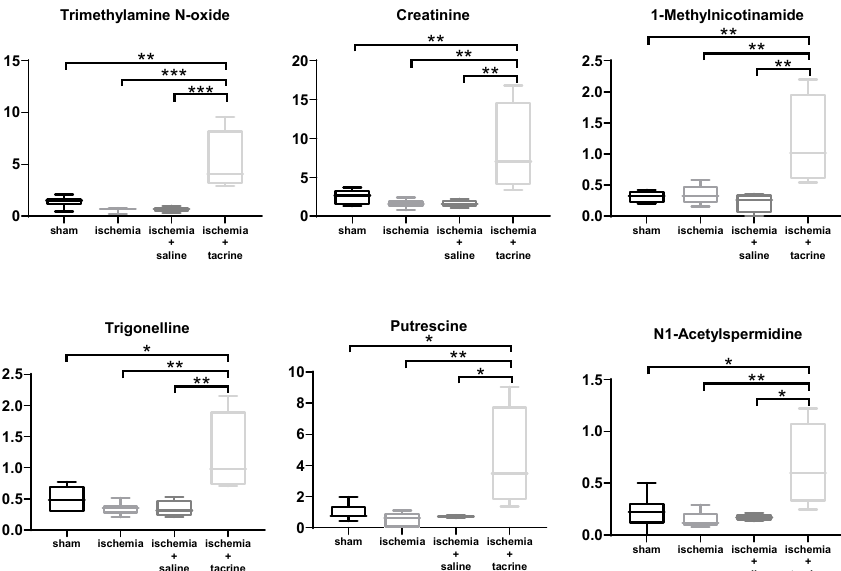
Figure 3. PLS-DA of salivary metabolite concentrations. ( A ) Score plots. ( B ) VIP scores. The metabolite detected in detec- tion limits in more than 50% of the samples were selected and, of these, the metabolites showing variance value within the top 50% were analyzed. A total of 42 metabolites were used. The developed model yielded R 2 = 0.72 and Q 2 = 0.40 using two principal components. ANOVA tests were conducted for each metabolite, and p -values were adjusted by FDA. The metabolites showing q -value < 0.05 are shown with * in the VIP score. The right four column panels indicate the heatmap of four groups. The labels (1)–(4) on the heatmap correspond to the groups shown in ( A ), e.g., (1) sham group.